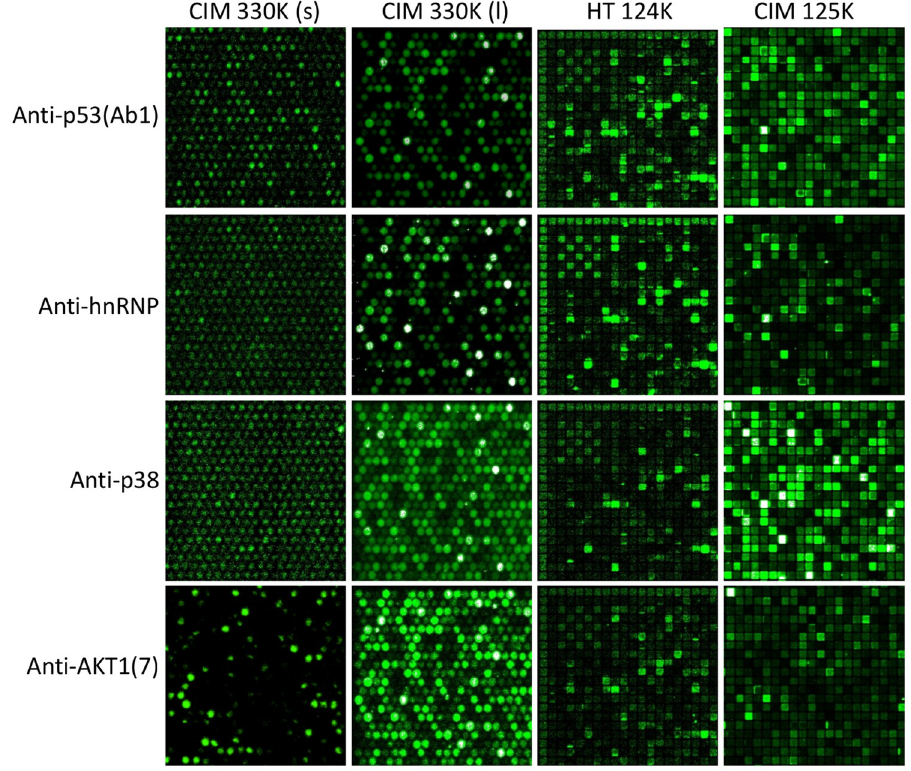
Fig 1. Raw images of a small portion of the upper-left portion of four different peptide microarrays showing four different monoclonal antibodies. The X axis is four different peptide libraries; CIM330K (short) is a library of 330,000 random-sequence peptides of length 12.2 residues; CIM 330K (long) is a library of 330,000 random-sequence peptides of length 17 residues. HT124K is a library of 124,000 random-sequence peptides of length 9 residues; CIM125K is a library of 125,000 peptides of mean length 12 residues. The Y axis is four commercially-sourced monoclonal antibodies. Row 1: anti-human TP-53 (Ab1) has low binding to most peptides but very high binding to a small subset of peptides, especially to those containing the sequence RHSVV. Row 2: anti-human hnRNP monoclonal has an intermediate binding prevalence, with approximately 15% of the total peptides binding at > 2SD above background. Row 3: anti-human p38 monoclonal has low binding pattern but at least 15% of all peptides bind at least 2SD above background with a few high binders. Row 4: anti-AKT1(7) monoclonal has more promiscuous binding with > 40% of all peptides binding > 2SD above background for HT124K and CIM125K. This visual display is intended to demonstrate qualitatively how diverse the binding patterns